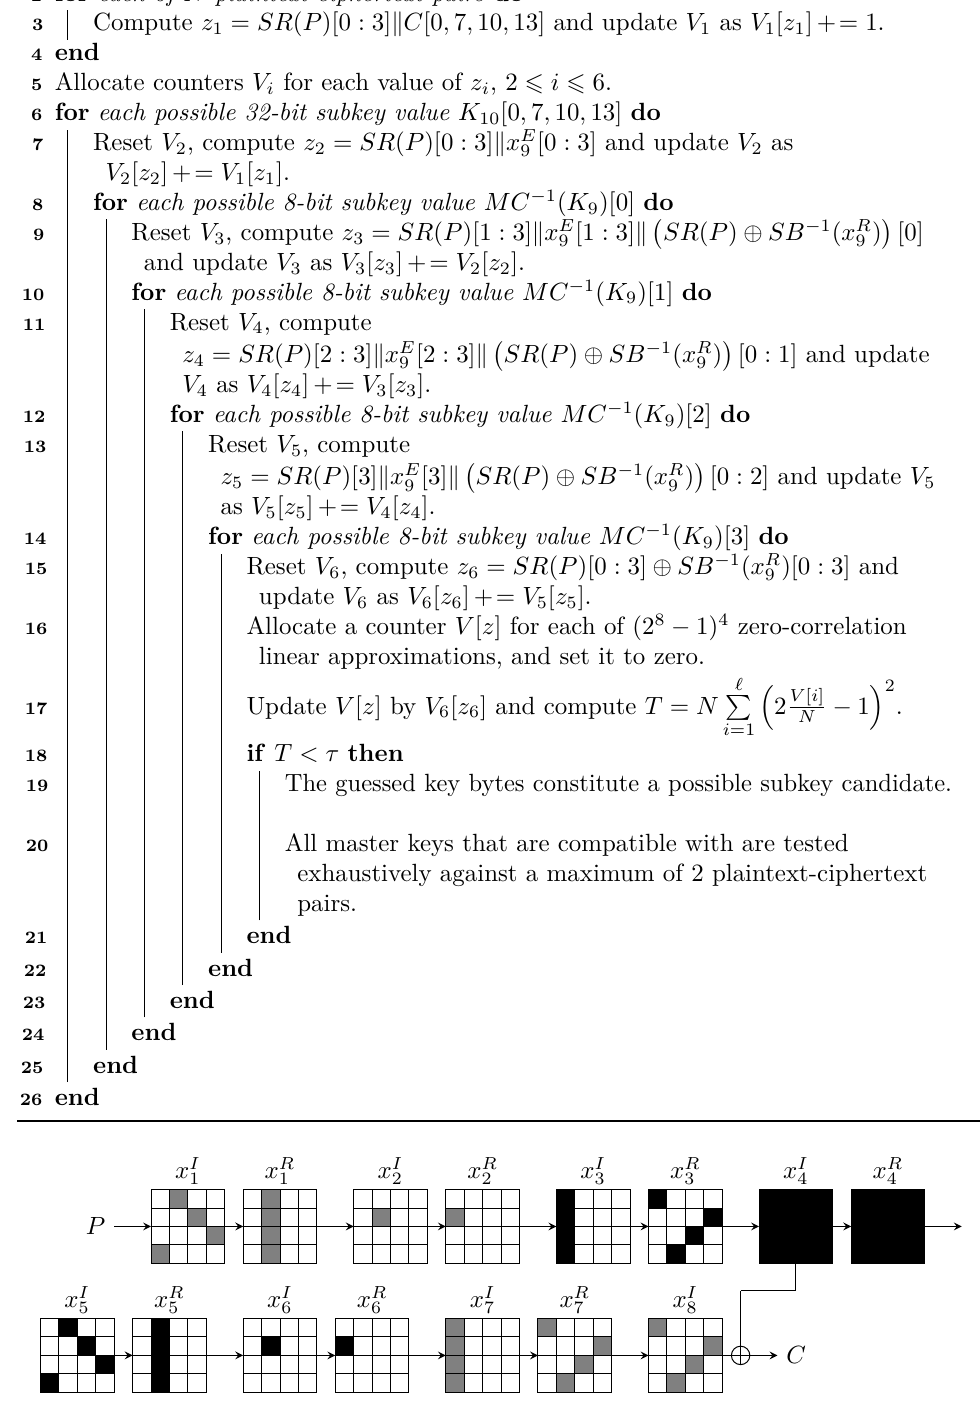
Figure 14: Truncated differential characteristic on AES-PRF 3 , 4 . Differences in white squares are